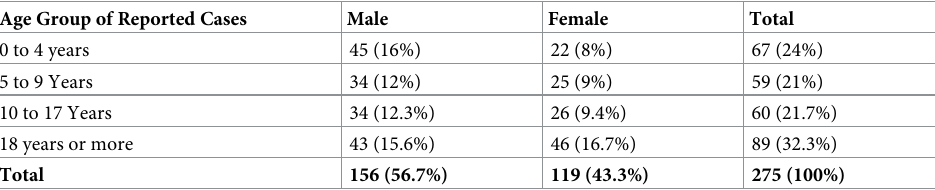
Table 2. Gender and age-group distribution of reported AJS